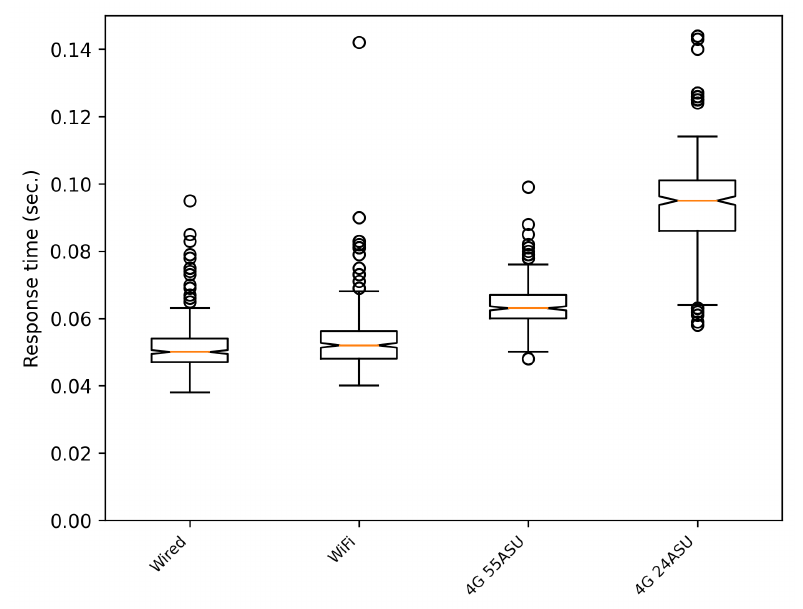
Figure 6. Response times for static clients with the UDP version with different types of network connections. The same results as Figure 5a with an appropriate